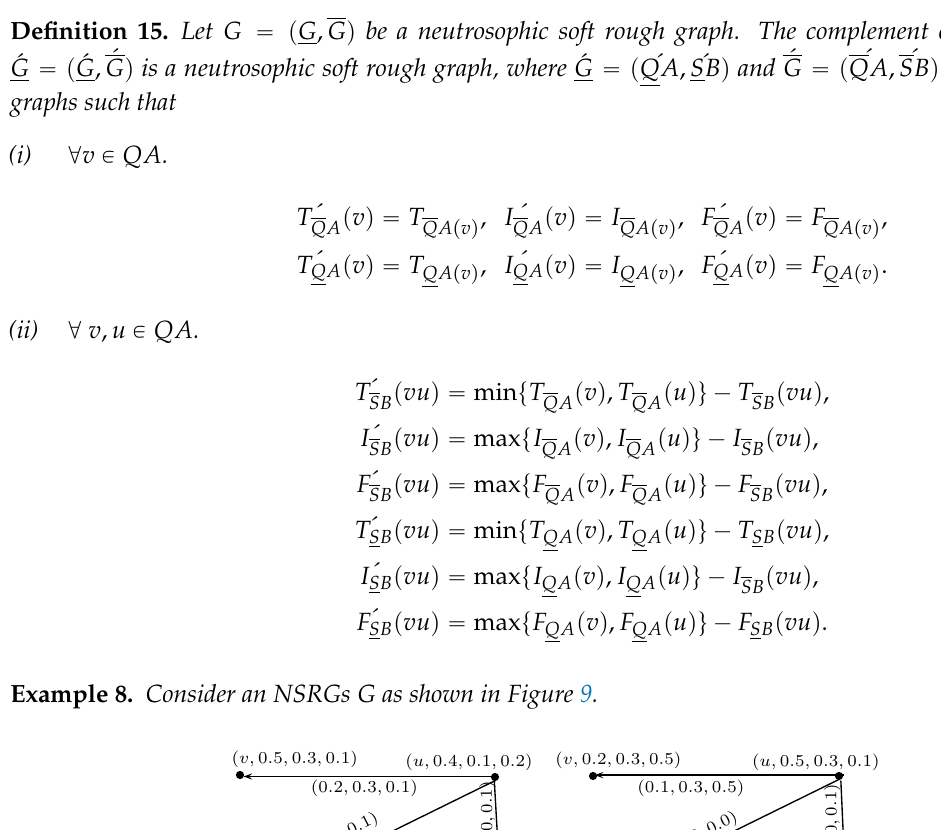
Figure 10: Neutrosophic soft rough graph ´ G = ( ´ G,